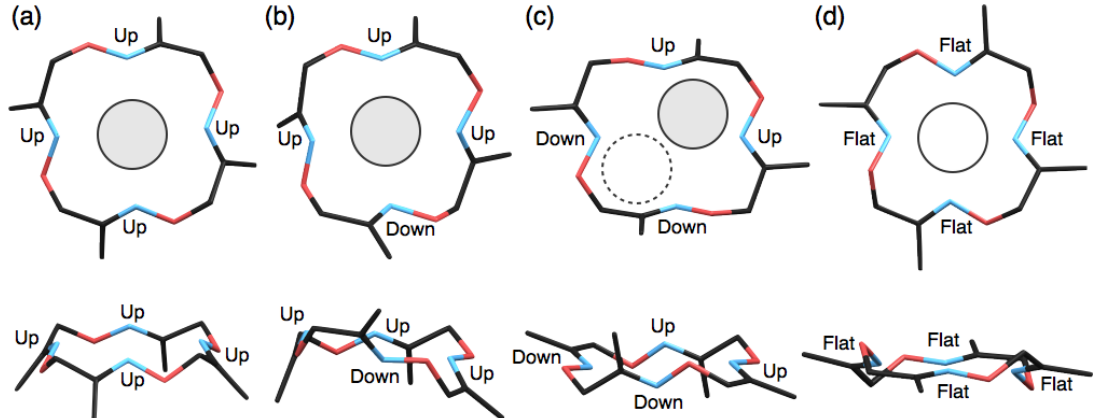
SO ]; ( b ) A flipped shuttlecock-like conformation 3 3 CO ] [16]; ( c ) A stair-like conformation in [Ag( 1 )] 3 2 CN) ](ClO ) 3 2 4 2